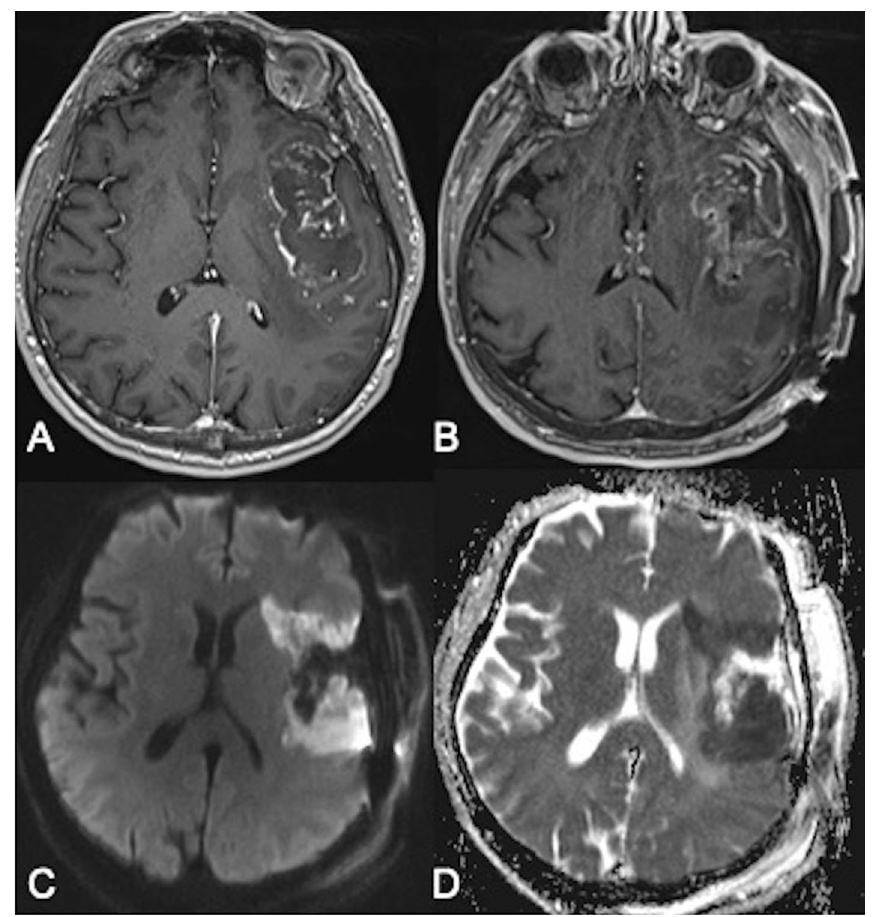
Figure 1. T1-weighted MRI with contrast of a 64 year-old male with an insular glioblastoma before ( A ) and after ( B ) surgery. Post-operative diffusion-weighted imaging ( C ) and apparent diffusion coefficient ( D ), showing a large wedge-shaped surgery-related